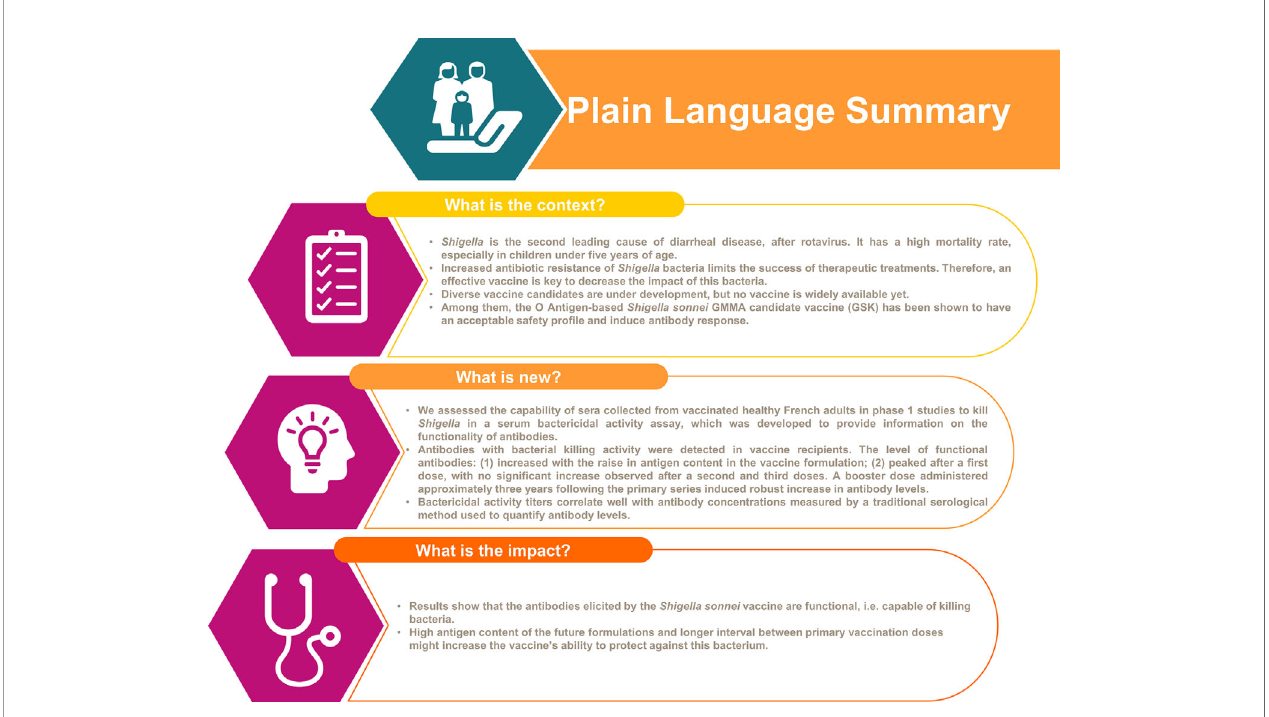
FIGURE 1 | Plain Language